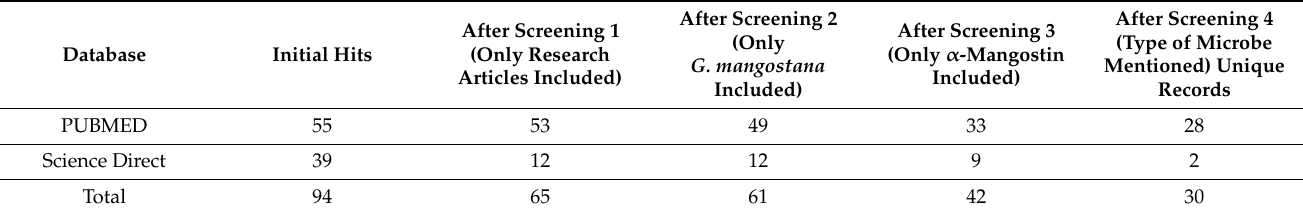
Table 4. Summary of the screening